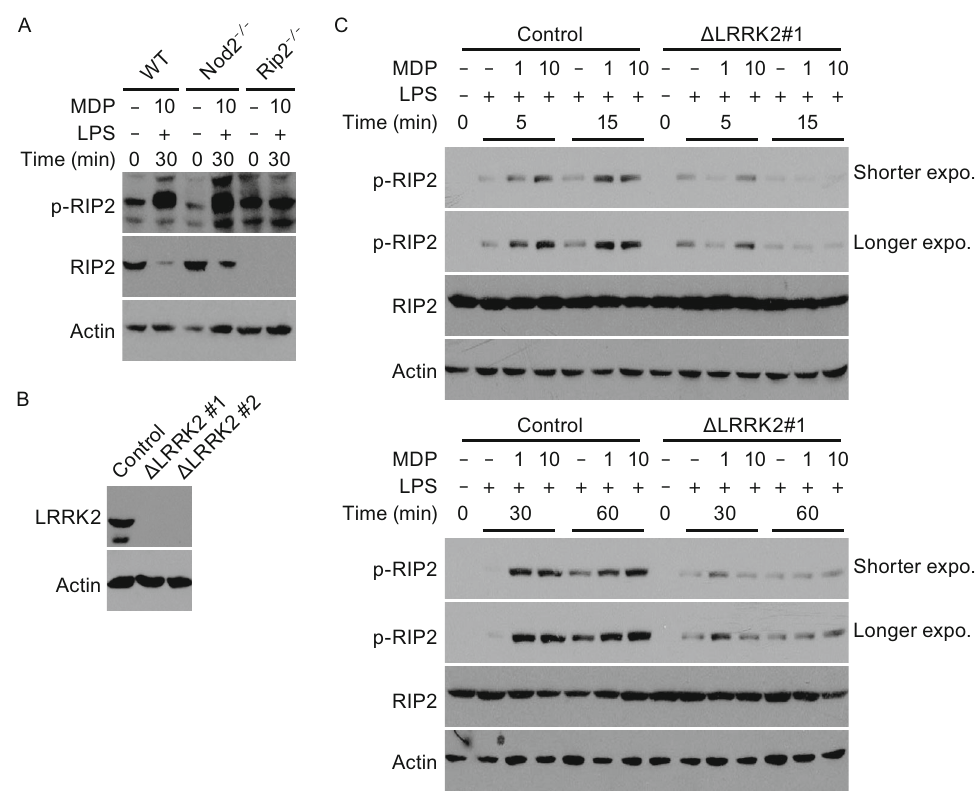
Figure 5. LRRK2 affects phosphorylation of Rip2 in human macrophages. (A) Immunoblotting of phosphorylated murine Rip2 (S176) in WT, Nod2 − / − , and Rip2 − / − BMDMs using the commercial antibody against phosphorylated human (S176). BMDMs